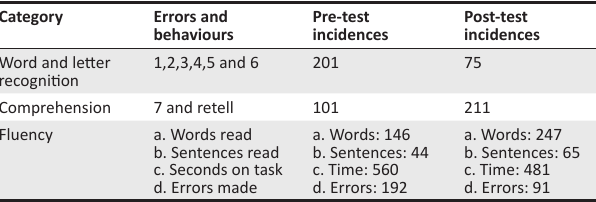
TABLE 1: Learner group 1 (LG1) categorisation of reading